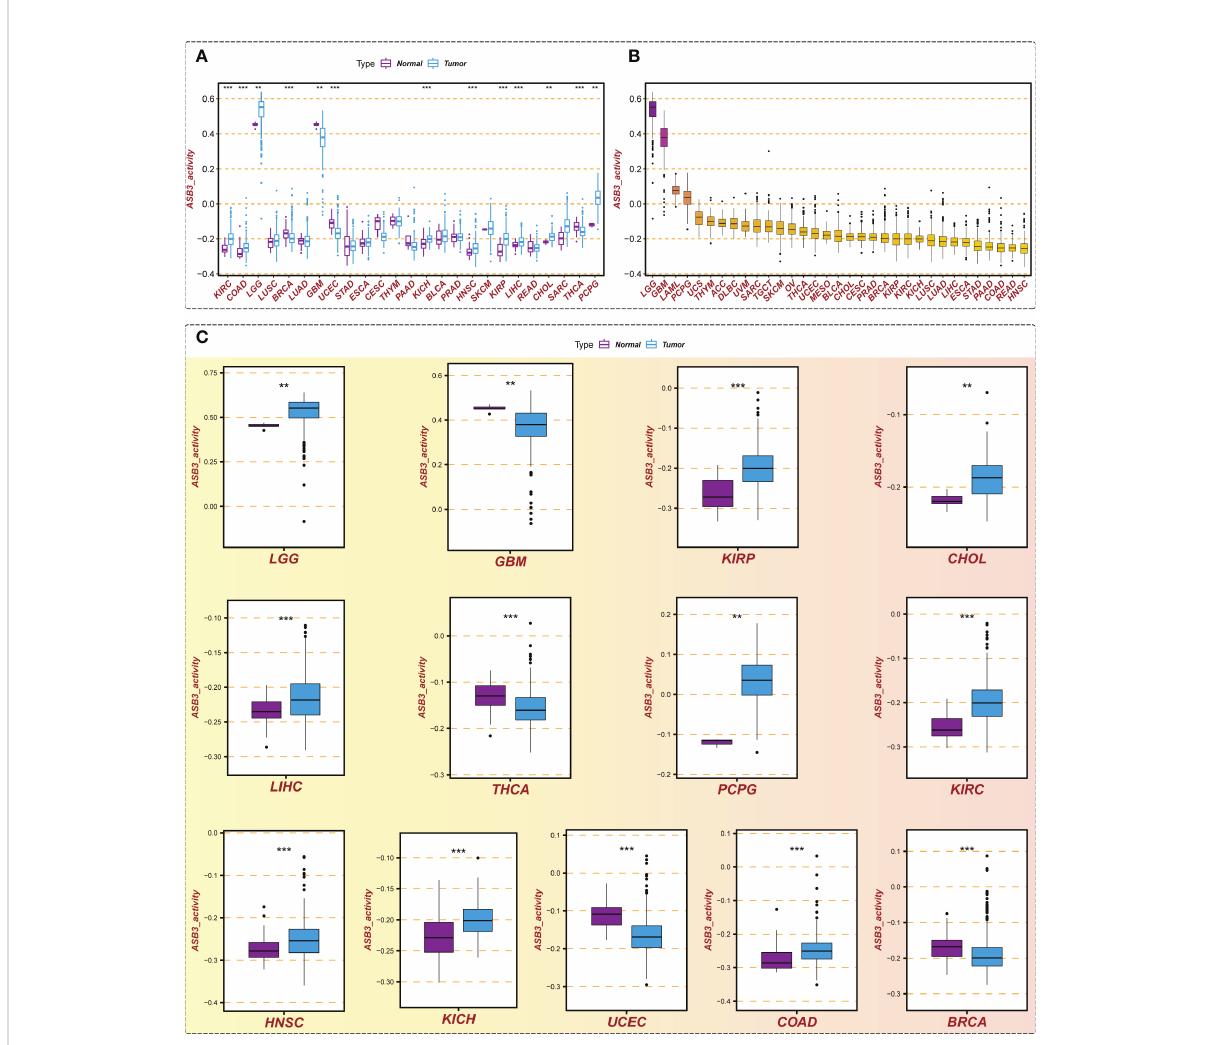
FIGURE 3 Gene activity of ASB3 in pan-cancer. (A) Comparison of ASB3 gene activity in a variety of cancers, increased in 9 cancer types and decreased in 4 cancer types. (B) The gene activity level of ASB3 in pan-cancer, LGG and GBM have the highest gene activity level. (C) Box plots showing the signi fi cant different activity of ASB3 across tumor and normal sample in 13 cancer types. ** P < 0.01, *** P <